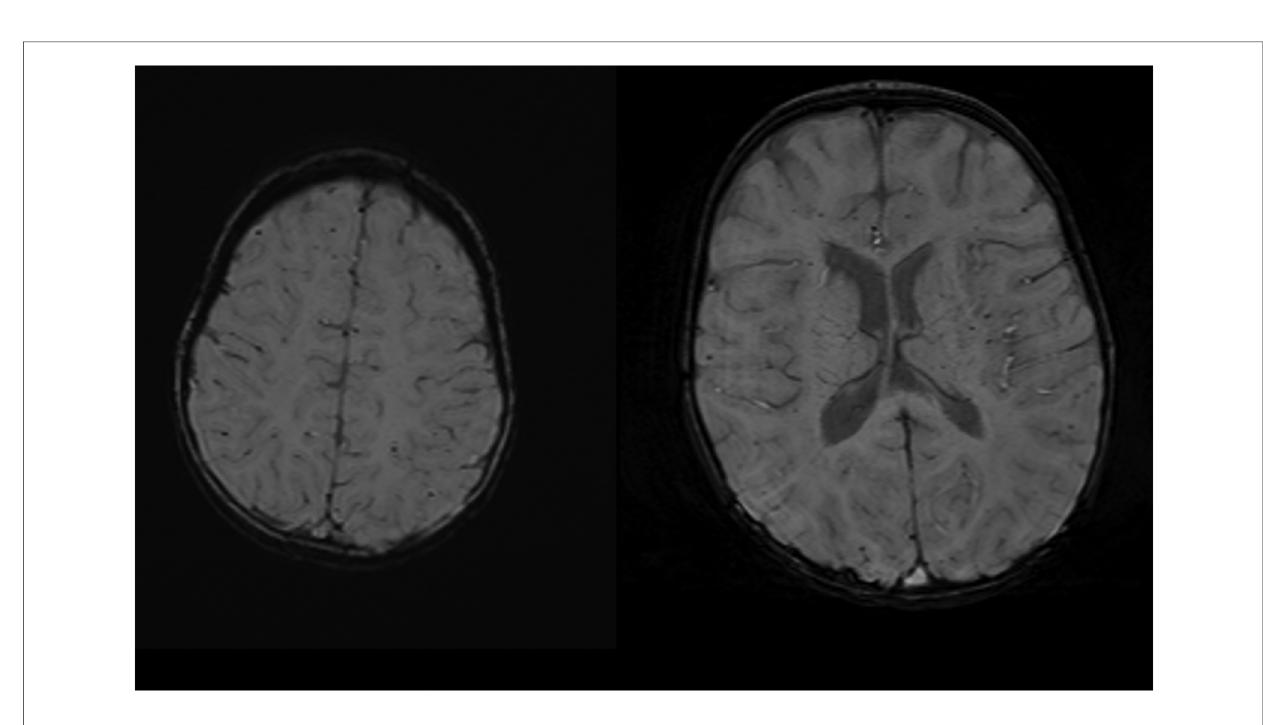
FIGURE 2 MRI screening with micro hemorrhagic foci in two patients without